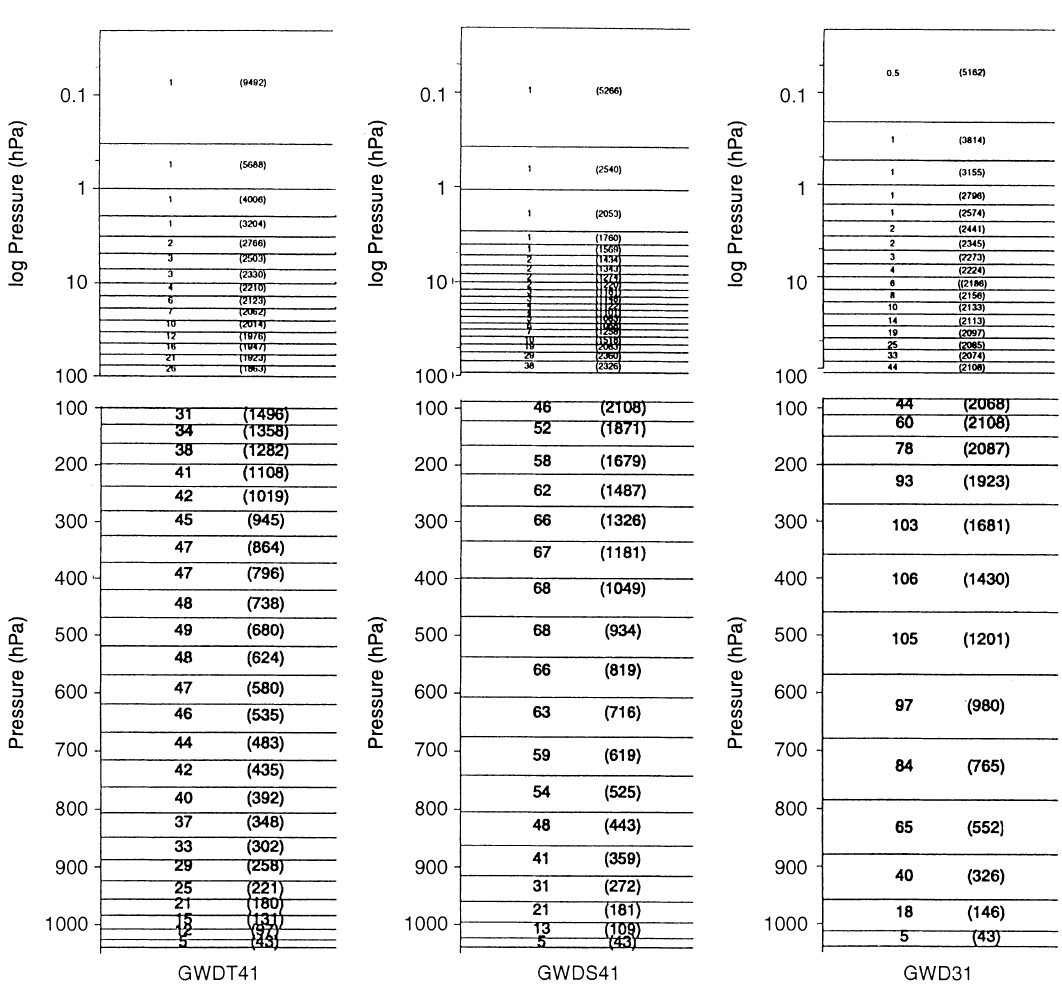
Fig. 6. Vertical layer structure of the experiments GWD31, GWDS41 and GWDT41, in a linear scale below level 100 hPa (in the troposphere) and in a logarithmic scale above level 100 hPa. Pressure